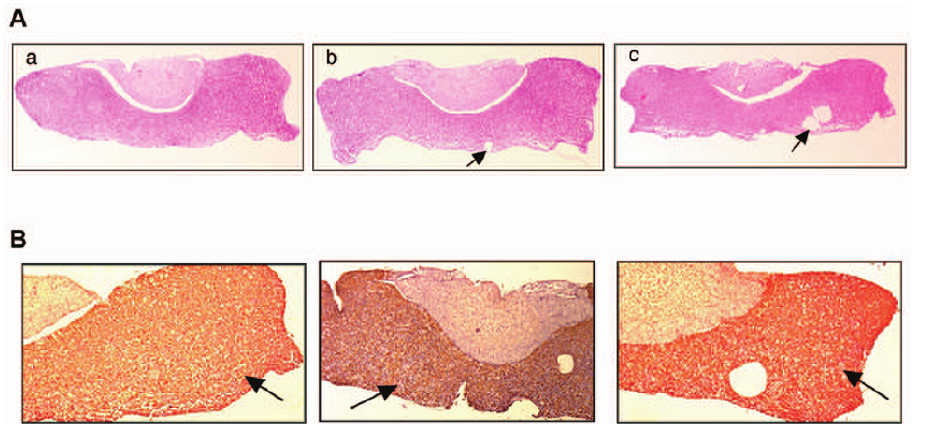
Figure 3. Pars distalis abnormalities and immunostaining. ( A ) Histological features of the pars distalis. H&E stained sections of pars distalis were examined in the 14-wk-old control (a), aged-nulliparous (b) and aged-multiparous (c) mice. Note the presence of cysts in the aged- nulliuparous (panel b) and aged-multiparous (panel c) females (arrow). Cysts were undetectable in the control 14-weeks-old (panel a) mice. ( B ) prolactin Immuno- histochemistry analysis of the pars distalis of 14-wk-old (a), aged-nulliparous (b) and aged-multiparous (c) mice showed uniform positive staining for prolactin in the control and experimental mice. Stained images illustrate the location of prolactin positive cells (arrows). Magnification 5 6 .